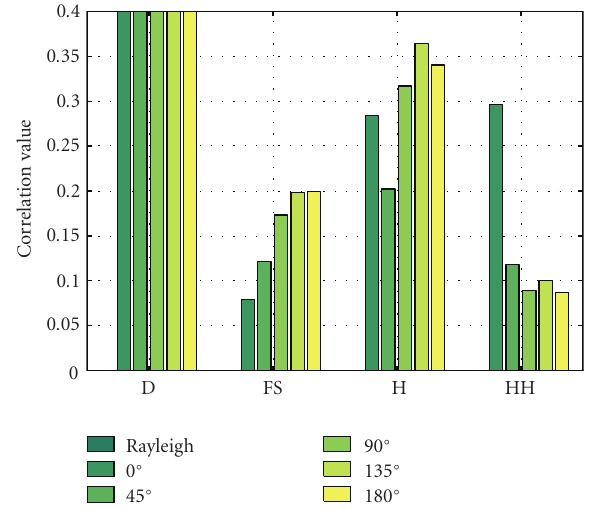
Figure 11: Channel correlation values in the di ff erent usage scenarios at di ff erent user orientations.